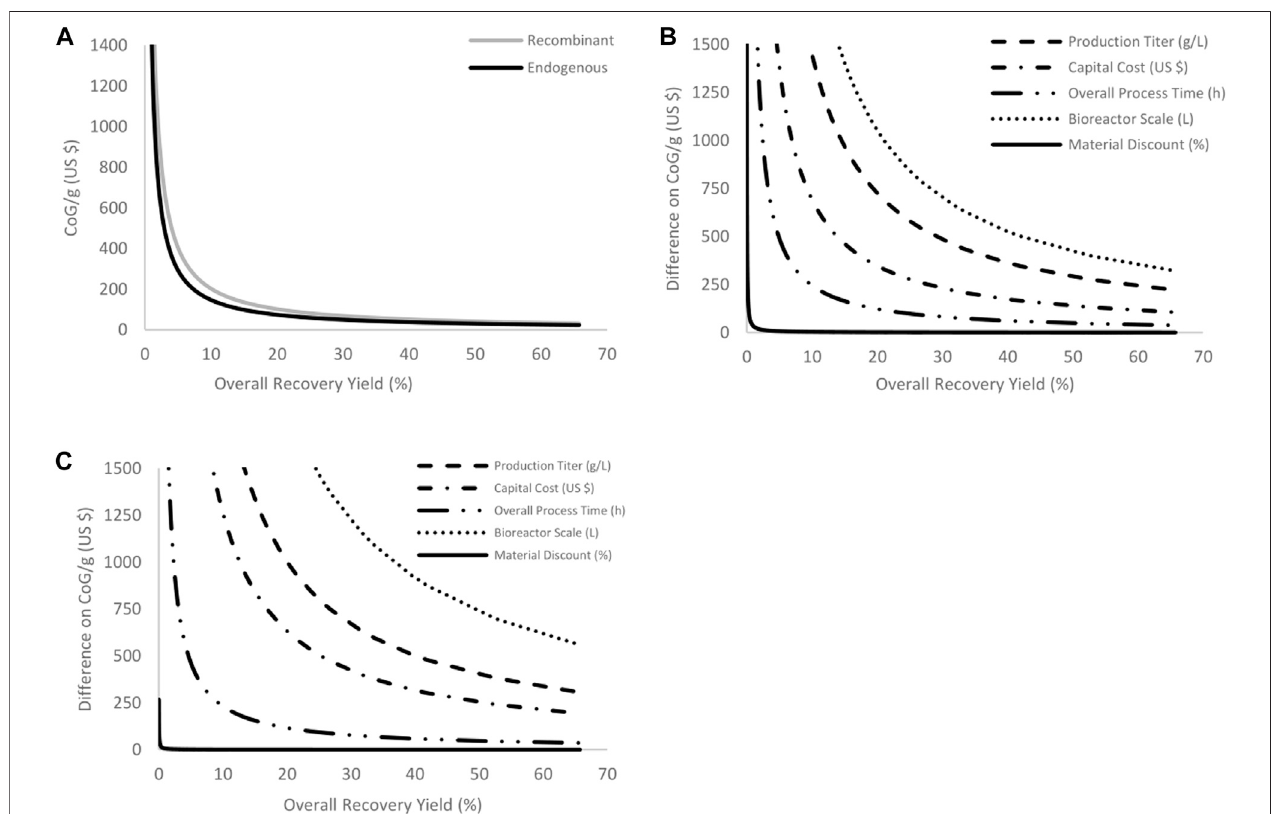
FIGURE 2 | Results from the sensitivity analysis performed on endogenous and recombinant production. Variables analyzed comprise production titer, capital costs, overall process time, bioreactor scales, materials discount and overall recovery yield. (A) presents basal results for both production options at all recovery yields evaluatedwhentheremainingvariablesareat1X,operatingat100 Lwith0%materialsdiscount. (B) (endogenous)and (C) (recombinant)showsthedifferencebetween the maximum and minimal CoG/g when each variable was